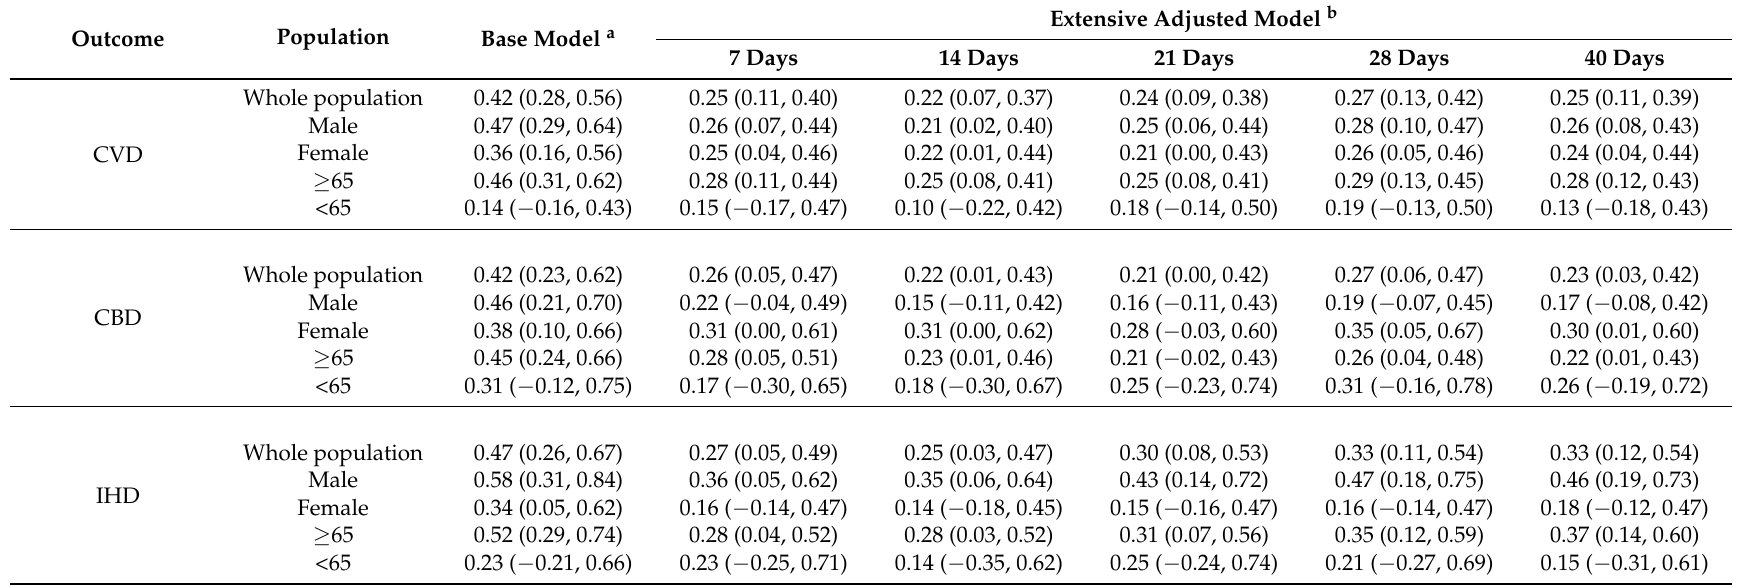
Table 3. Percent increase (95% CI) in risk of death associated with per 10 ug/m 3 increase in PM 2.5 by gender, age group and death causes based on models with different extensive adjustments for cumulative effects of both temperature and relative humidity